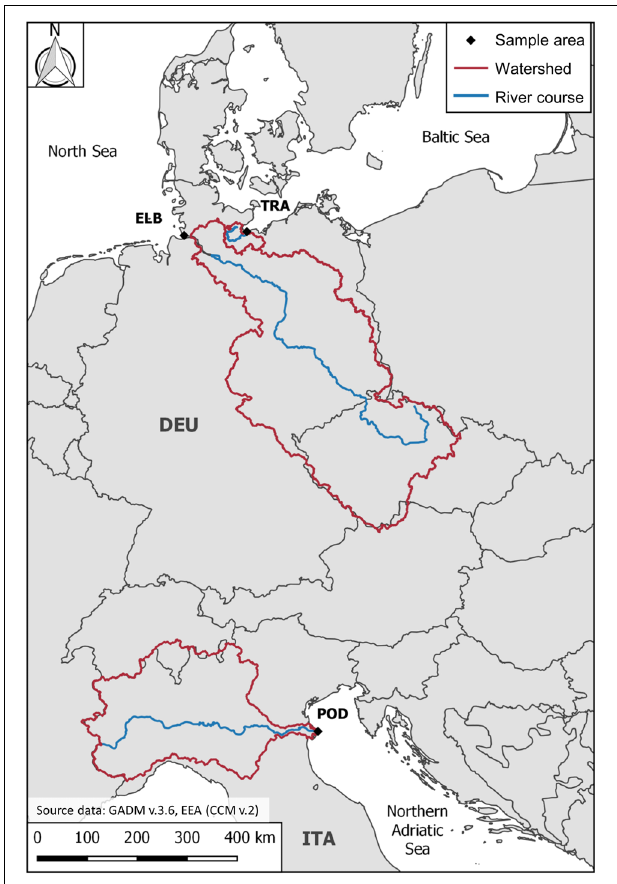
FIGURE 1 | Study areas of the Trave (TRA) and the Elbe estuary (ELB) in Germany (DEU) and the Po delta (POD) in Italy (ITA), course of the rivers and their respective